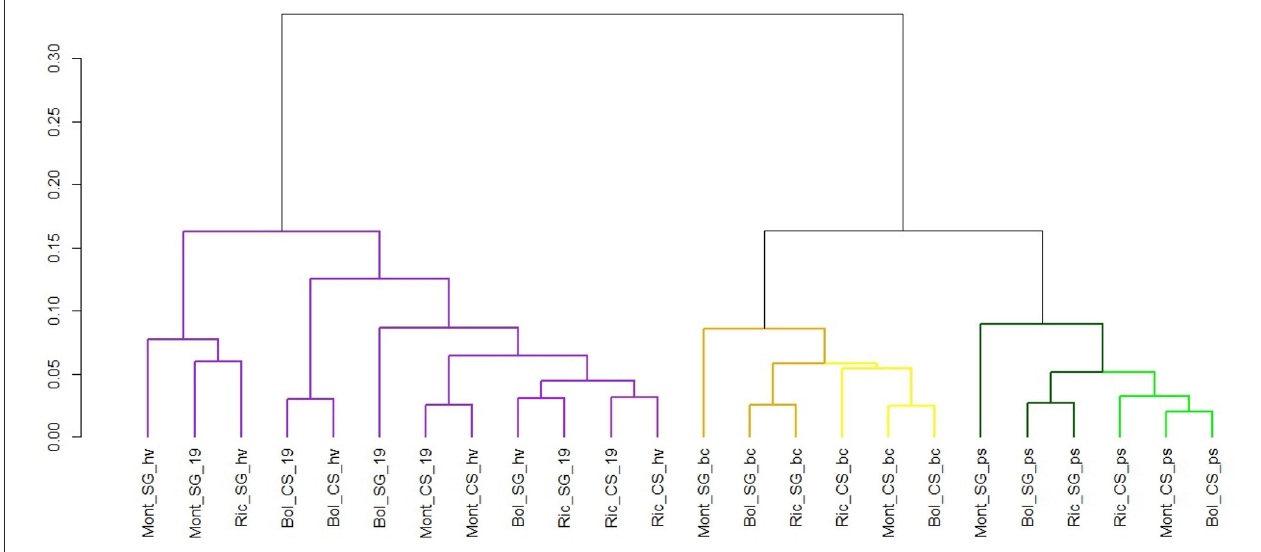
FIGURE 10 | Cluster dendrogram showing global relationships of miRNAs expressed in different grapevine cultivars, collected in different vineyards and developmental stages. The Pearson correlation coefficients, calculated based on the abundance of expressed miRNAs in each library, were converted into distance coefficients to define the height of the dendrogram. Different colors distinguish different clusters of samples. Library codes can be found in Table 1